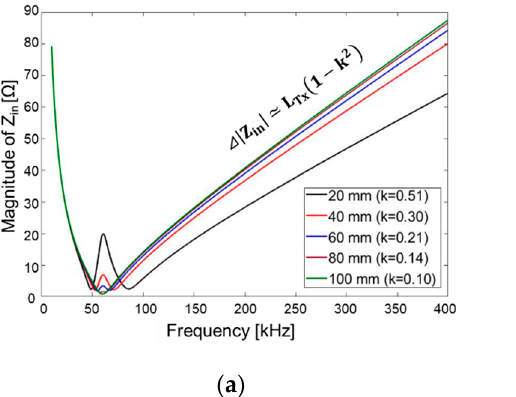
Figure 13. Change in input impedance according to air gap (coupling coefficient): ( a ) input impedance magnitude change according to frequency change; ( b ) input impedance phase change according to frequency change.